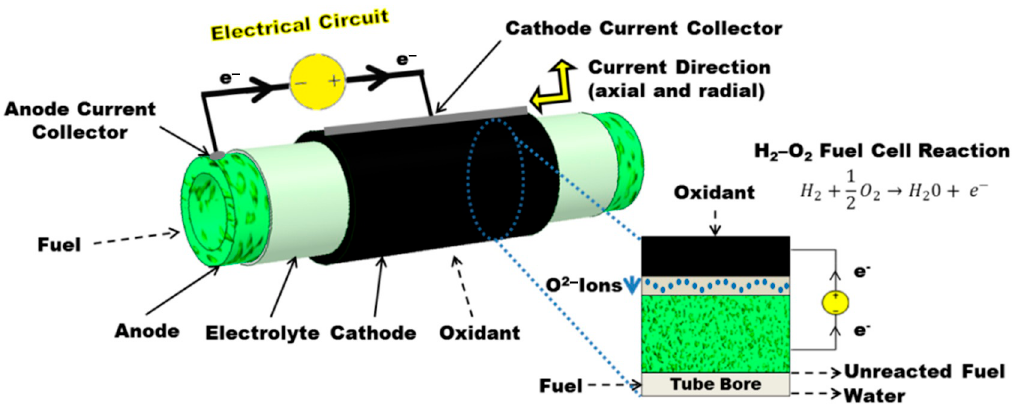
Figure 2. Tubular solid oxide fuel cell schematic with cross-sectional view, operating principle and current direction.